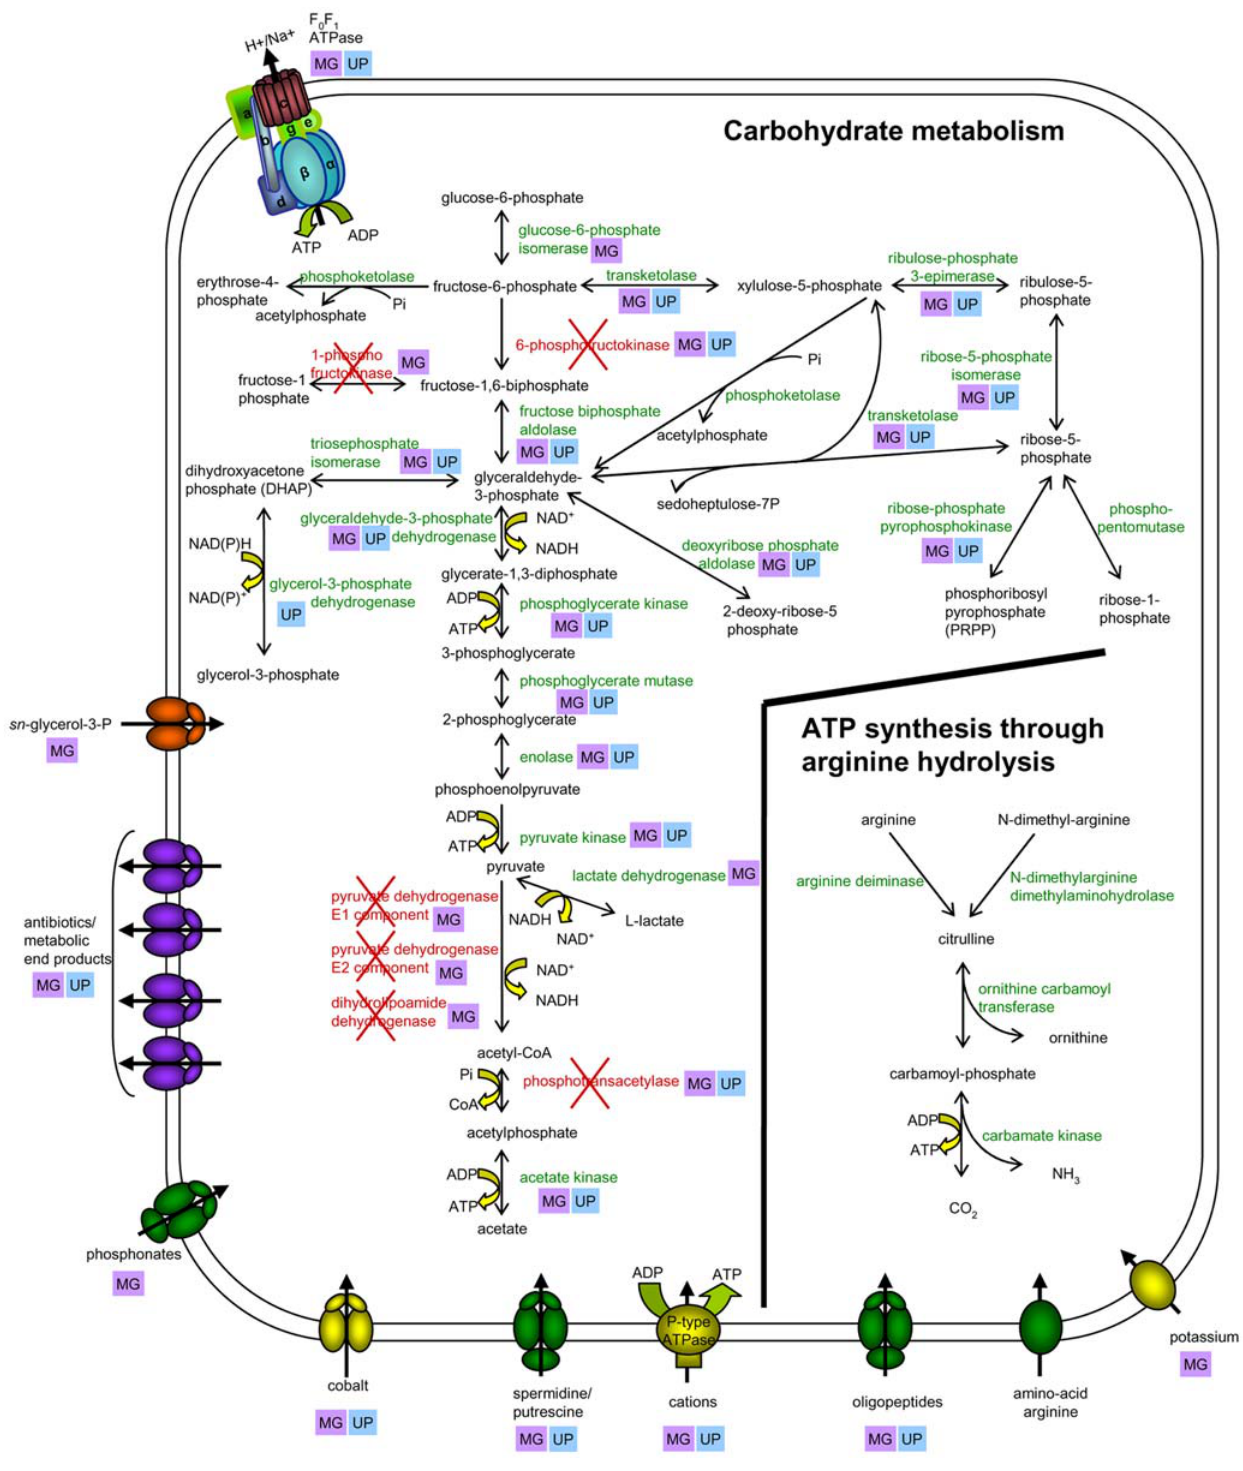
Figure 2. Comparison of carbohydrate- and arginine-metabolism pathways and transporters encoded by M.hominis PG21, M. genitalium G37, and U.parvum serovar 3. Metabolic products are shown in black. Putative proteins present in M. hominis are shown in green; proteins absent from M. hominis are shown in red. ‘‘MG’’ in purple boxes indicates that the gene encoding the corresponding protein is present in the M. genitalium G37 genome. ‘‘UP’’ in blue boxes means that the gene encoding the corresponding protein is present in the U. parvum genome. Transporters are colored according to their substrates: yellow, cations; green, anions and amino-acids; orange, carbohydrates; purple, multidrug and metabolic end product efflux. Arrows indicate the direction of substrate transport.